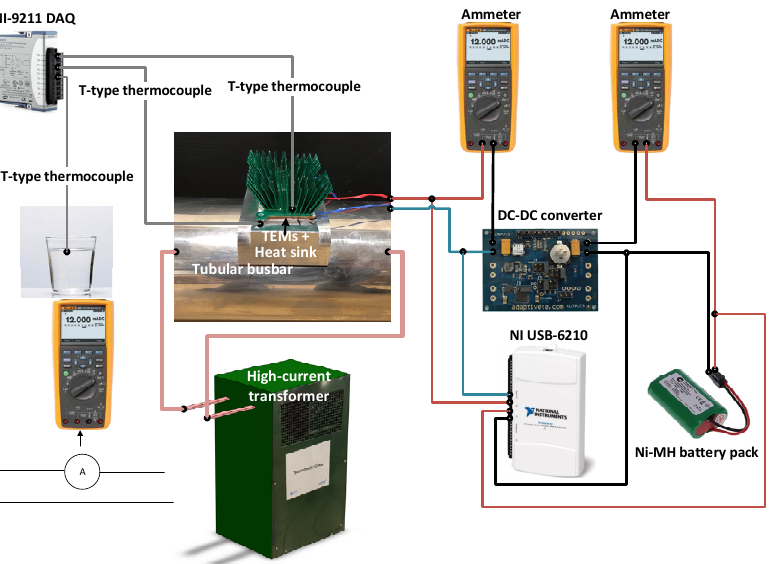
Figure 3. Experimental setup to test the behavior of the energy harvesting system mounted on a tubular busbar.